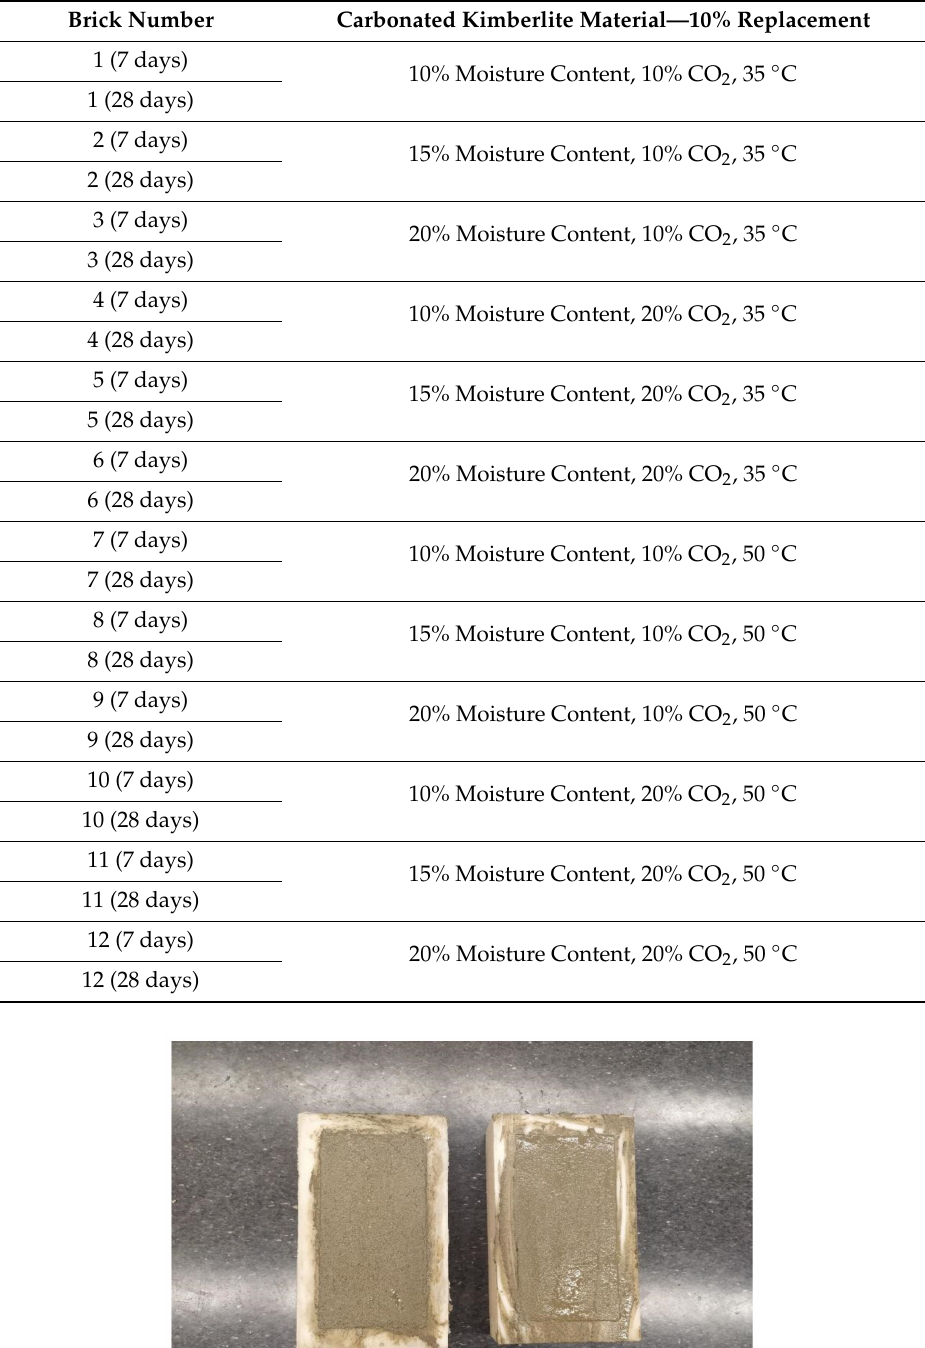
Table 1. The brick numbers that specify its curing duration and the carbonated kimberlite sample used. Brick Number